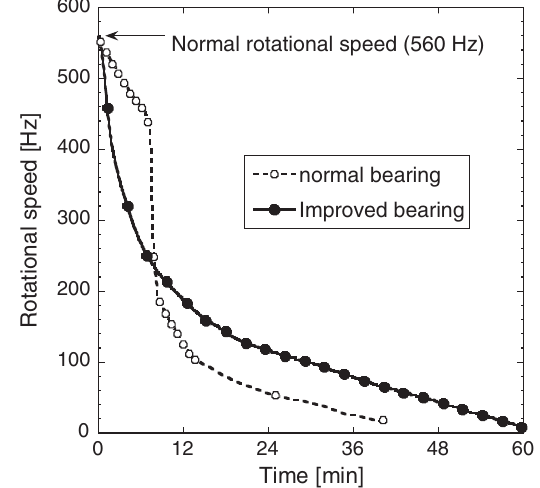
FIG. 13. Change of the rotor rotation speed against the time in the FRTD test for the TMP with the normal bearing and improved one. The origin of the horizontal axis is the time of the rotor touch